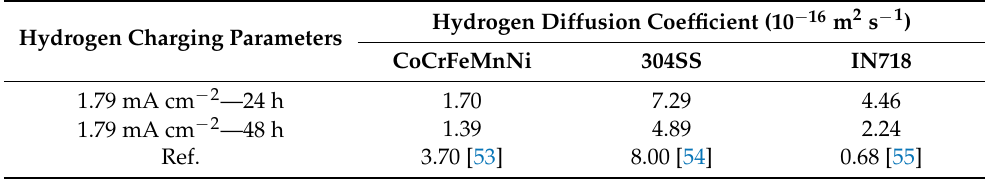
Table 5. Calculated hydrogen diffusion coefficient of CoCrFeMnNi, 304SS, and IN718 alloy. Hydrogen Charging